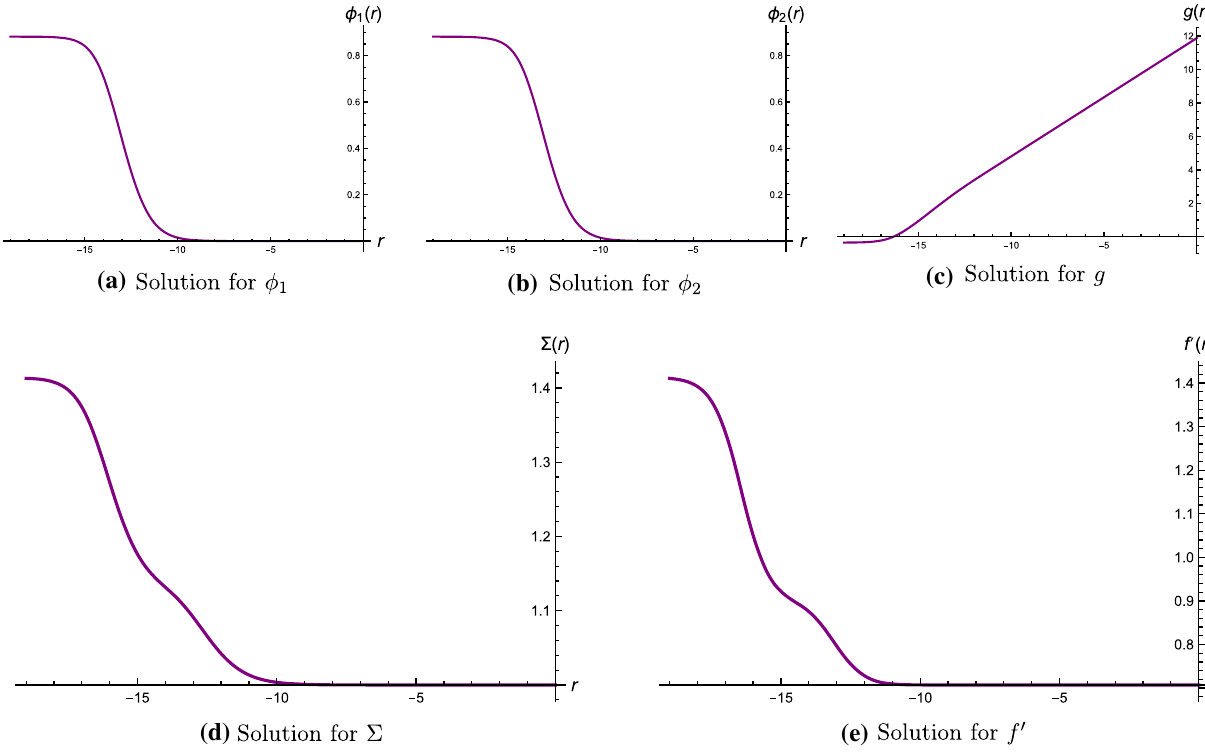
Fig. 4 An RG flow from AdS 5 critical point with U ( 1 ) × SU ( 2 ) × SU ( 2 ) symmetry to AdS 5 critical point with U ( 1 ) × SU ( 2 ) diag symmetry and finally to AdS 3 × H 2 critical point II for g 1 = 1 and g 3 = 2 g